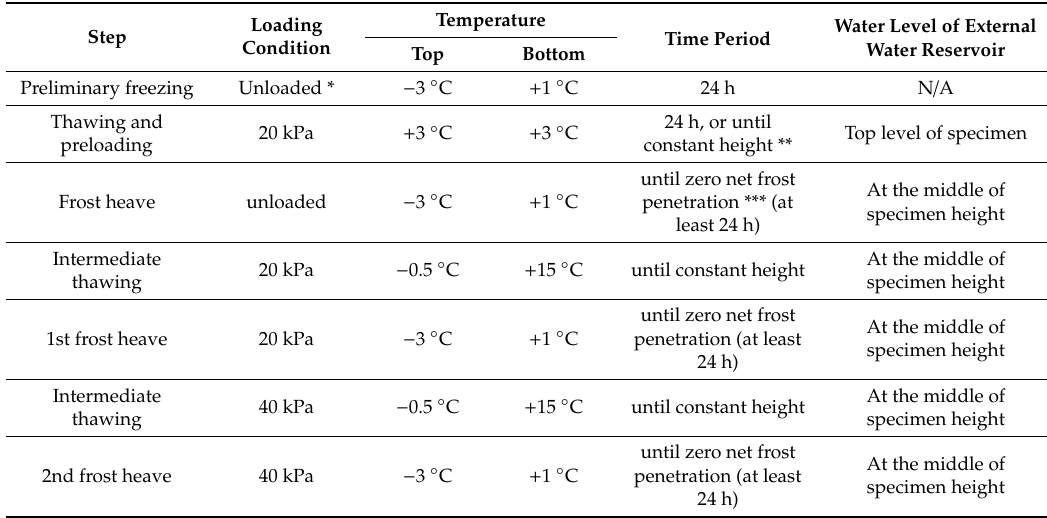
Table 2. Frost heave and thawing conditions adopted in the